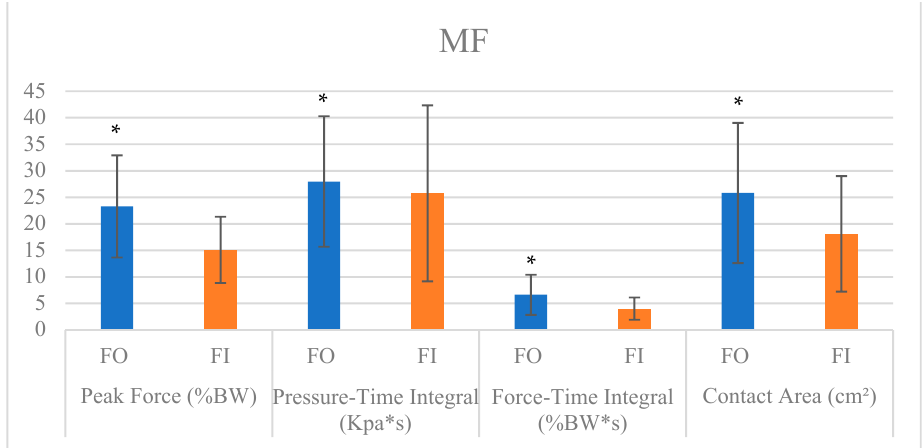
Figure 5. Plantar pressure and contact area of midfoot (MF) with customized foot orthosis (FO) or flat insoles (FI). * p < 0.05.